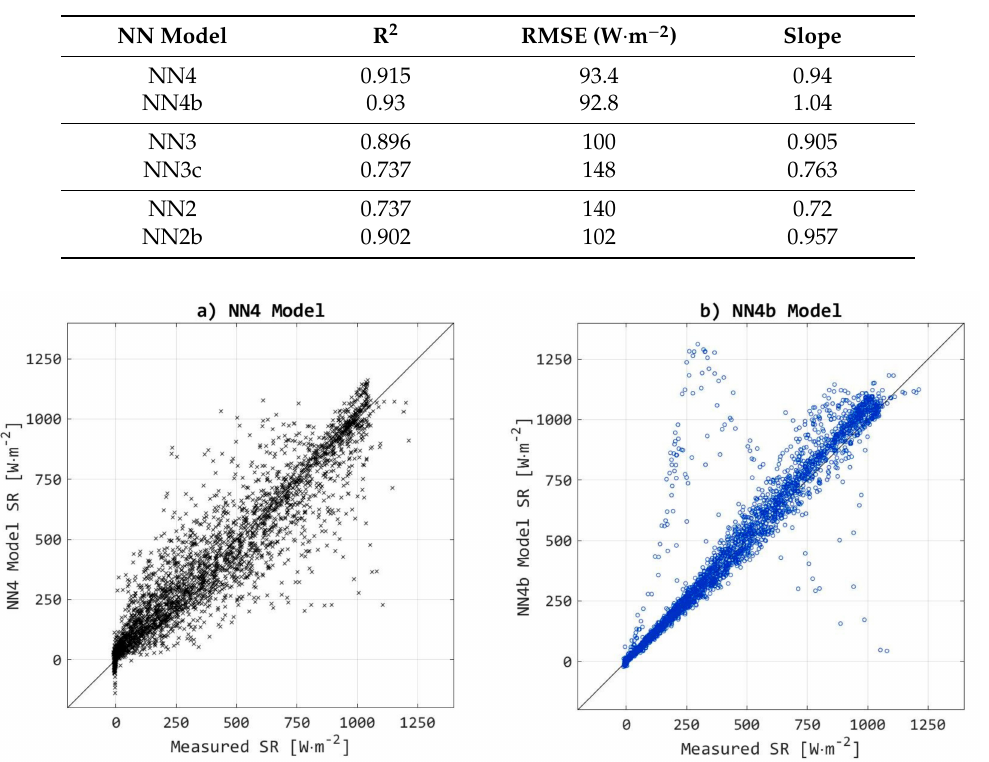
Table 4. NN models outputs compared to measured shortwave radiation. Data from training periods was excluded; samples included only data recorded on 1 April to 20 May, and 11 to 19 June.